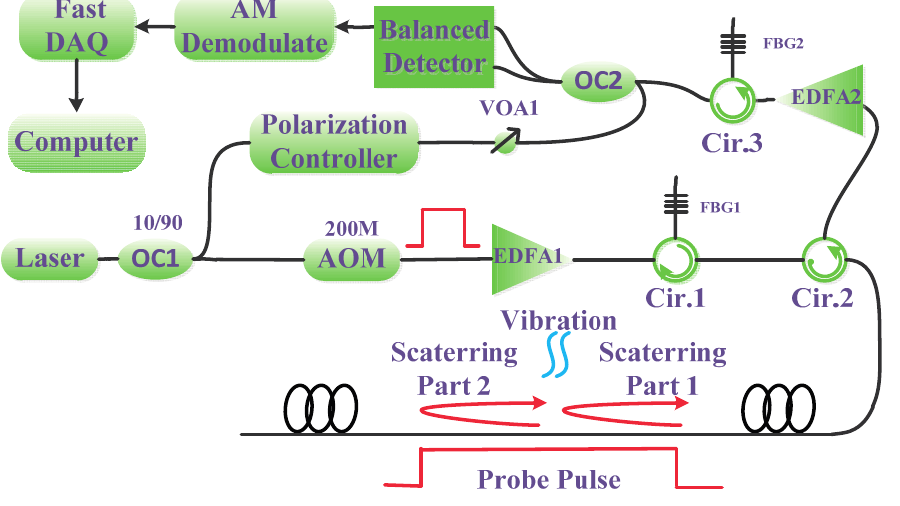
Figure 1. Experimental set up and